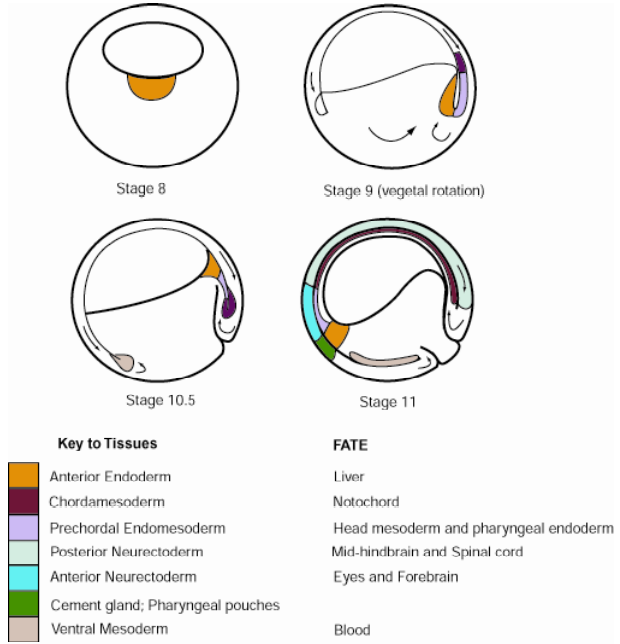
FIGURE 1. Differentiation of head organizer requires pregastrula interaction of the presumptive organizer with anterior endoderm. This figure illustrates the displacement of prospective anterior endoderm from deep within the vegetal half core to a position adjacent to the presumptive organizer by the process of vegetal rotation. It also shows the relative positions of anterior endoderm, prechordal mesoderm and chordamesoderm and their movement during gastrulation along the dorsal